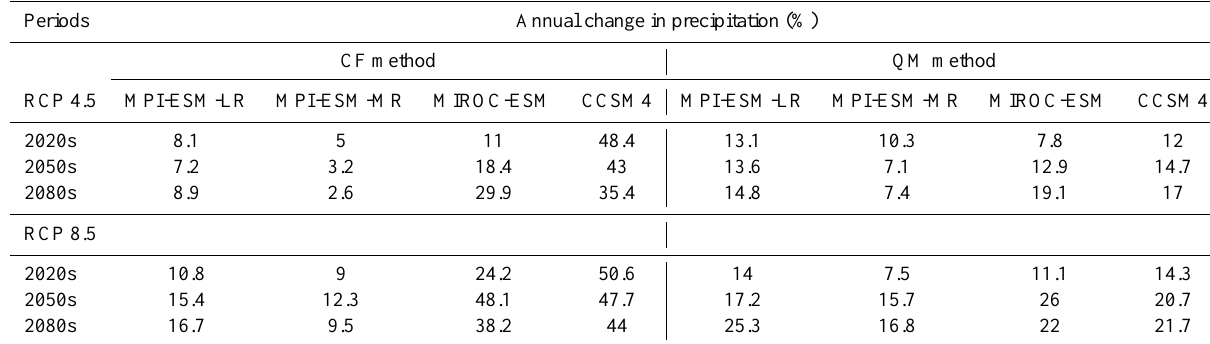
Table 7. Annual changes in precipitation in the future under the RCP4.5 and RCP8.5 scenarios for the GCMs. Periods Annual change in precipitation